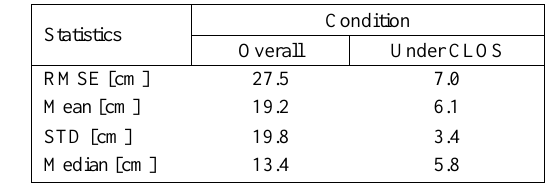
Table 2. Quantitative results from open-sky test.